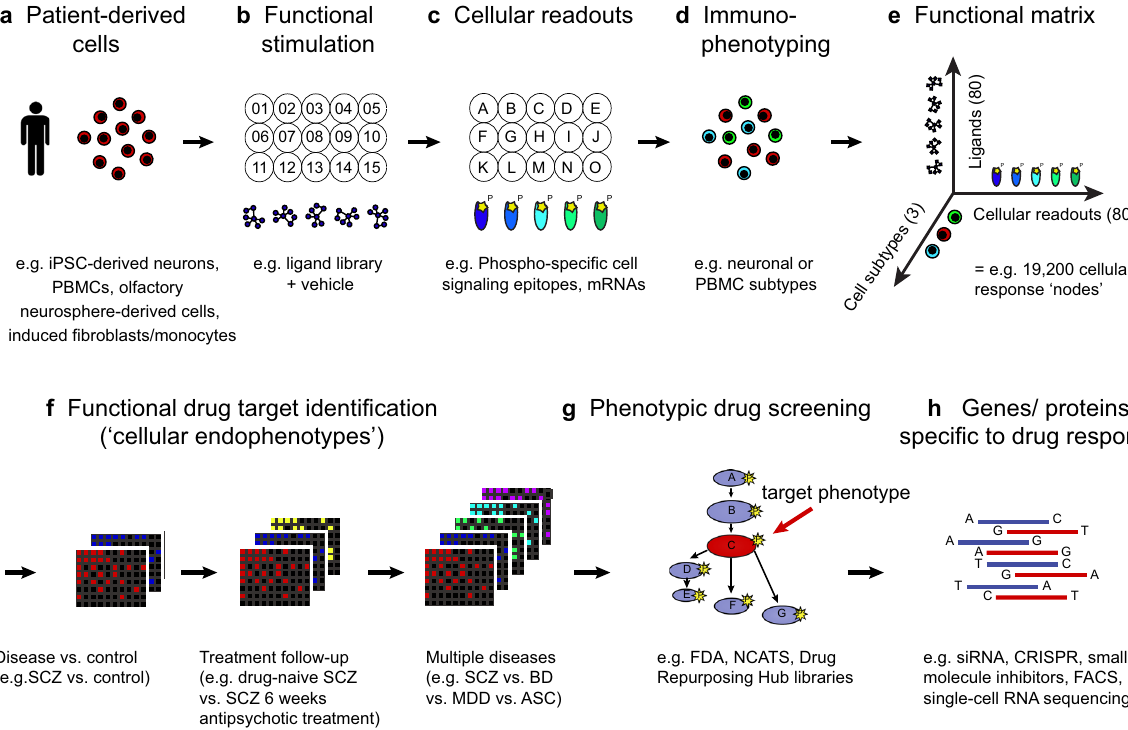
Fig. 2 Neuropsychiatric drug discovery pipeline based on functional cellular endophenotypes. a Human patient-derived cells (e.g., iPSC- derived neurons, PBMCs, olfactory neurosphere-derived cells and induced fi broblasts/monocytes) provide an accessible ex vivo model of physiologically relevant single-cell phenotypes in health and disease. b Patient-derived cells are stimulated using ligand libraries (e.g., 01 – 15) and vehicle. c Single-cell responses to the ligands are measured relative to the vehicle condition across an array of cellular readouts (e.g., phosphorylation of cell signaling epitopes or mRNA expression; A – O) and ( d ) multiple cell subtypes (e.g., neuronal or PBMC subtypes; red, blue and green) using high- content screening (e.g., fl ow cytometry, mass cytometry, high-throughput microscopy, multiplexed ion beam imaging and single-cell RNA sequencing). e This produces a combinatorial expansion of the number of functional assays (e.g., 80 ligands × 80 cellular readouts × 3 cell subtypes = 19,200 assays) performed in each patient-derived cell sample with each ligand-readout-cell subtype combination de fi ned as a cellular response ‘ node ’ . All nodes together provide a pro fi le of the functional repertoire of the cells from each donor. f Comparison of the node pro fi les between donors in different clinical groups allows the identi fi cation of abnormal cellular responses ( functional endophenotypes ) which are altered in the disease state (disease vs. control comparison), normalized by ef fi cacious clinical treatment (treatment follow-up comparison) and speci fi c to subsets of neuropsychiatric disorders (multiple disease comparison). g These abnormal functional endophenotypes (e.g., depicted in red on pathway A-G) can be targeted through phenotypic drug screening (red arrow) of compound libraries to identify novel drug candidates capable of restoring normal cellular network function. h Further mechanistic dissection of genes and proteins underlying the functional interaction between disease endophenotypes and drug mechanisms of action can be conducted using siRNA, CRISPR-Cas9 and small-molecule inhibitor counter-screens, fl uorescence-activated cell sorting (FACS) and single-cell RNA sequencing. SCZ schizophrenia, BD bipolar disorder, MDD major depressive disorder, ASC autism spectrum condition, FDA US Food and Drug Administration, NCATS National Center for Advancing Translational Sciences, CRISPR clustered regularly interspaced short palindromic repeats gene